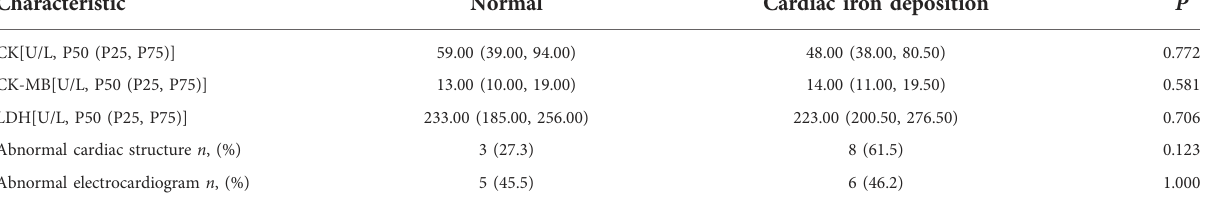
TABLE 5 Comparison of cardiac structure and